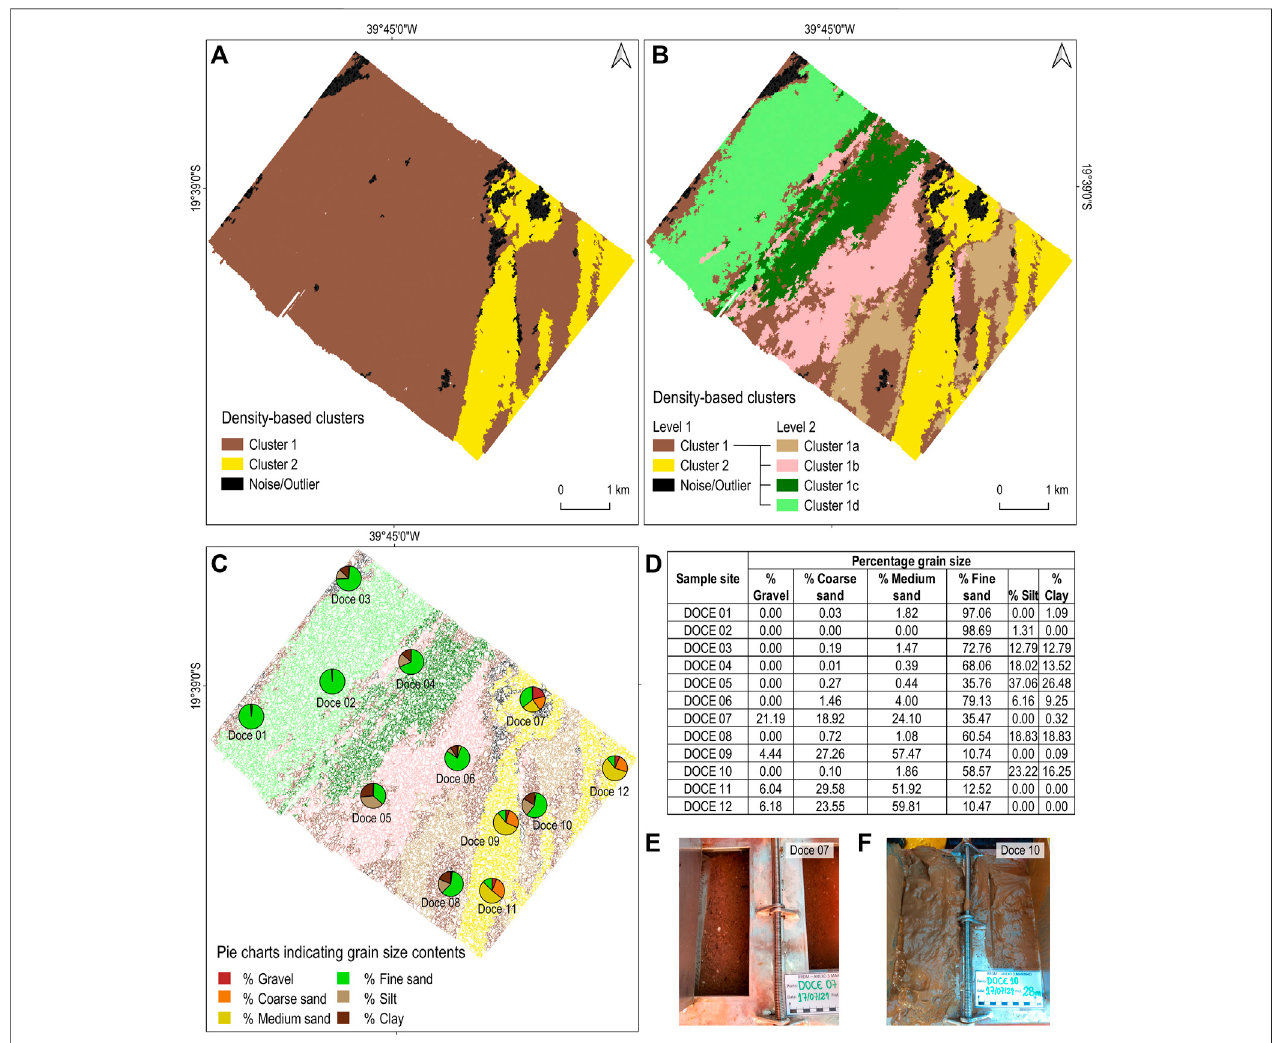
FIGURE 14 | (A) Density-based clusters predicting for the study area showing two main clusters; (B) clusters at detailed hierarchical level; (C) grain size results on top of clustering solution; (D) results of each grain size fraction for each sample; (E) sediment sample at Doce 07 sample site; (F) sediment sample at Doce 10 sample site.